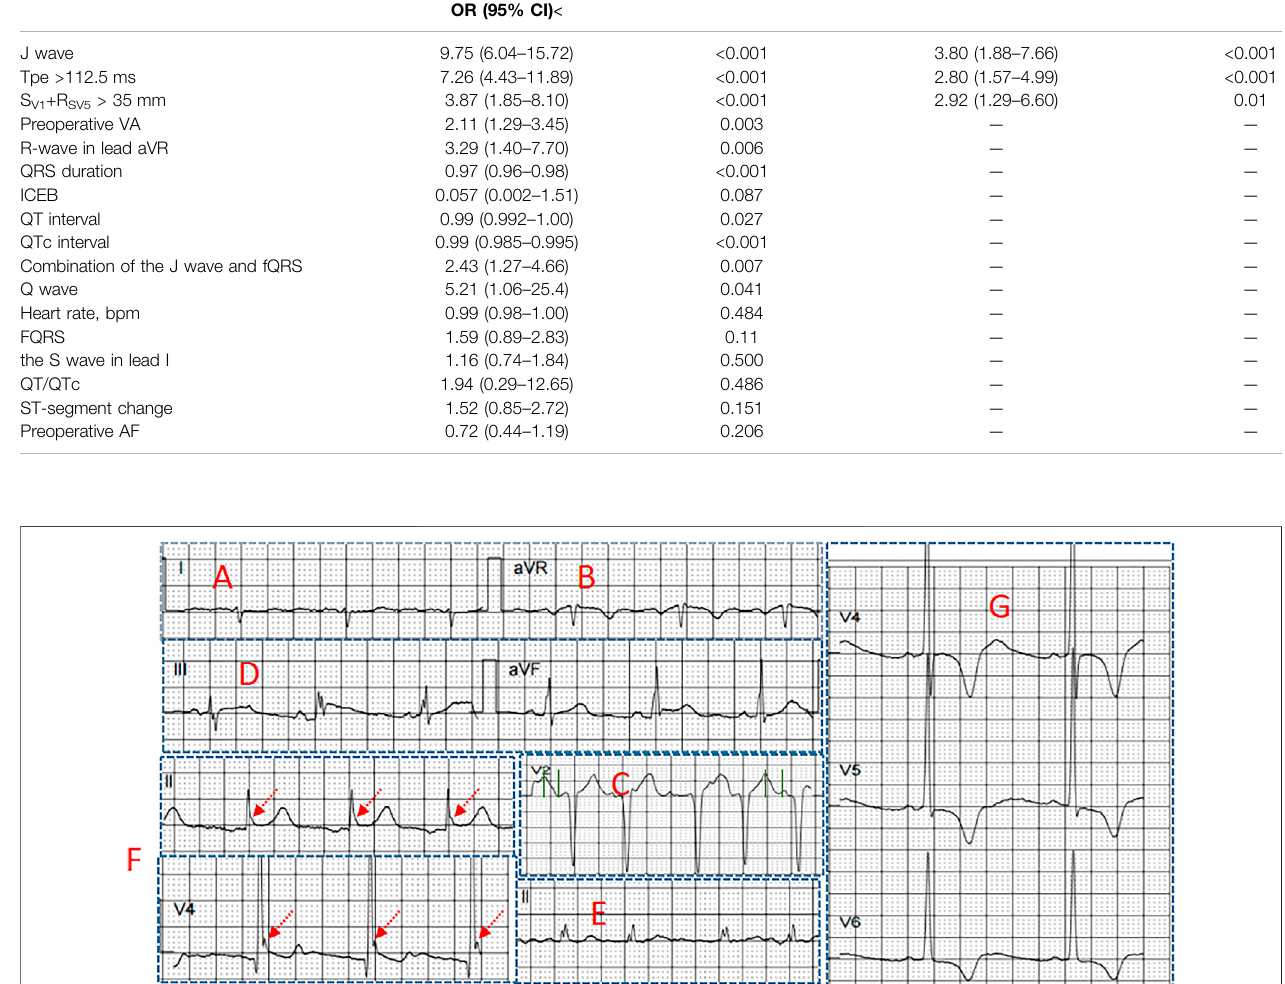
Frontiers in Physiology |